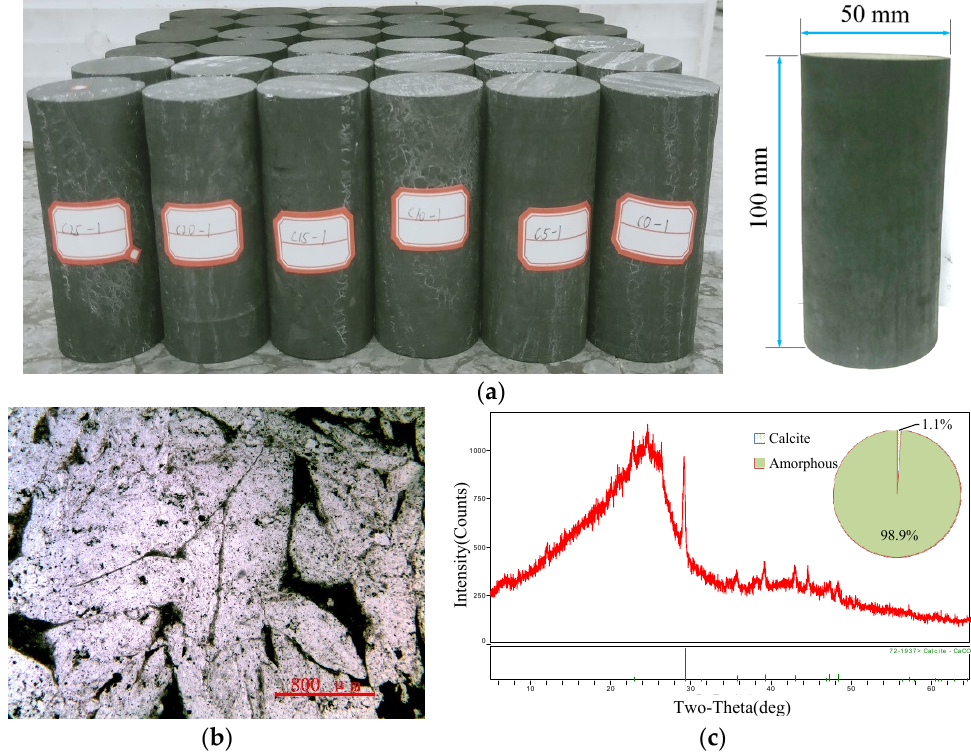
Figure 1. Processed coal samples and mineralogical features: ( a ) Processed coal samples; ( b ) Microscopic image; ( c ) X-ray Diffraction patterns.